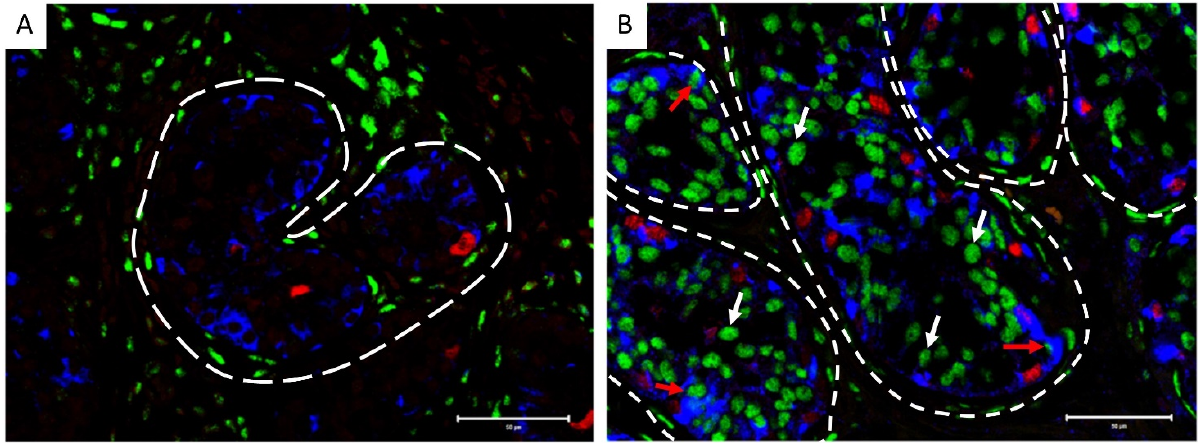
in Sertoli cells (Figure 9).